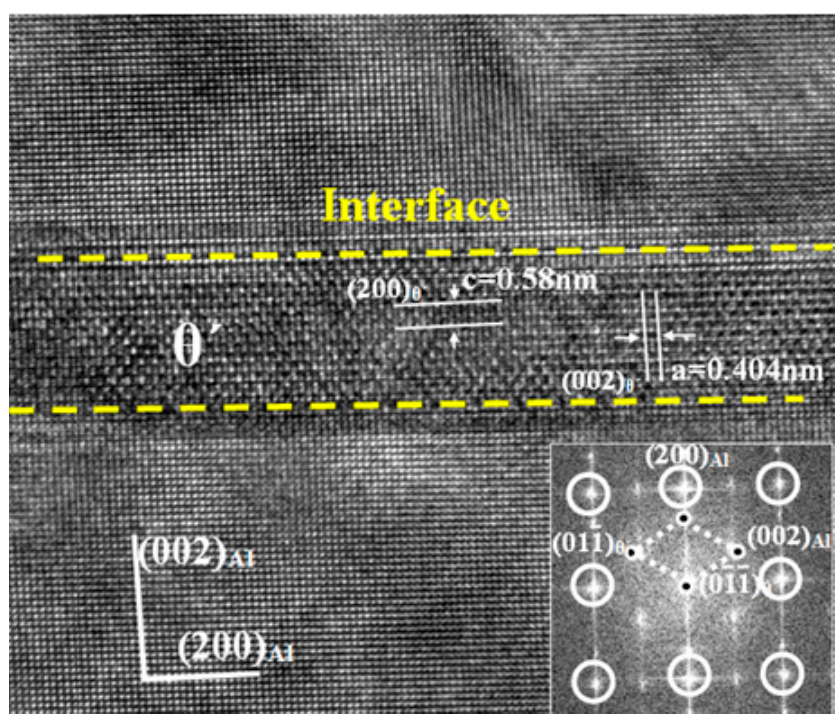
Figure 17. HRTEM image and corresponding FFT of lamellar precipitates in the peak-aged Alloy 3 (165 °C/540 min) observed via the <010> Al direction.